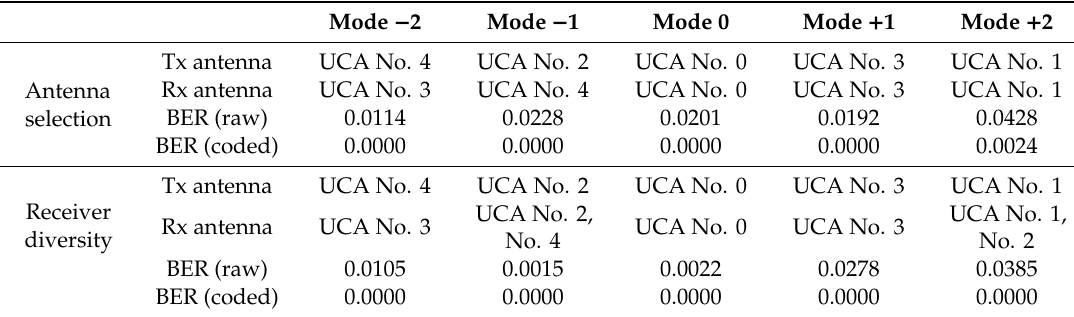
Table 3. Experimental results (OAM multiplexing).